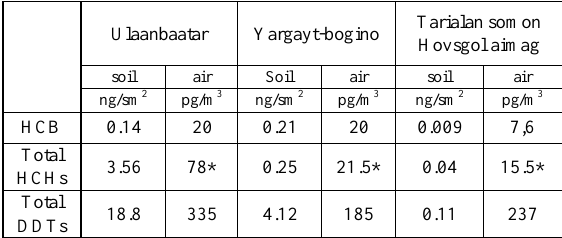
Table 2. The POPs accumulation levels in soil and concentrations in air from Mongolia